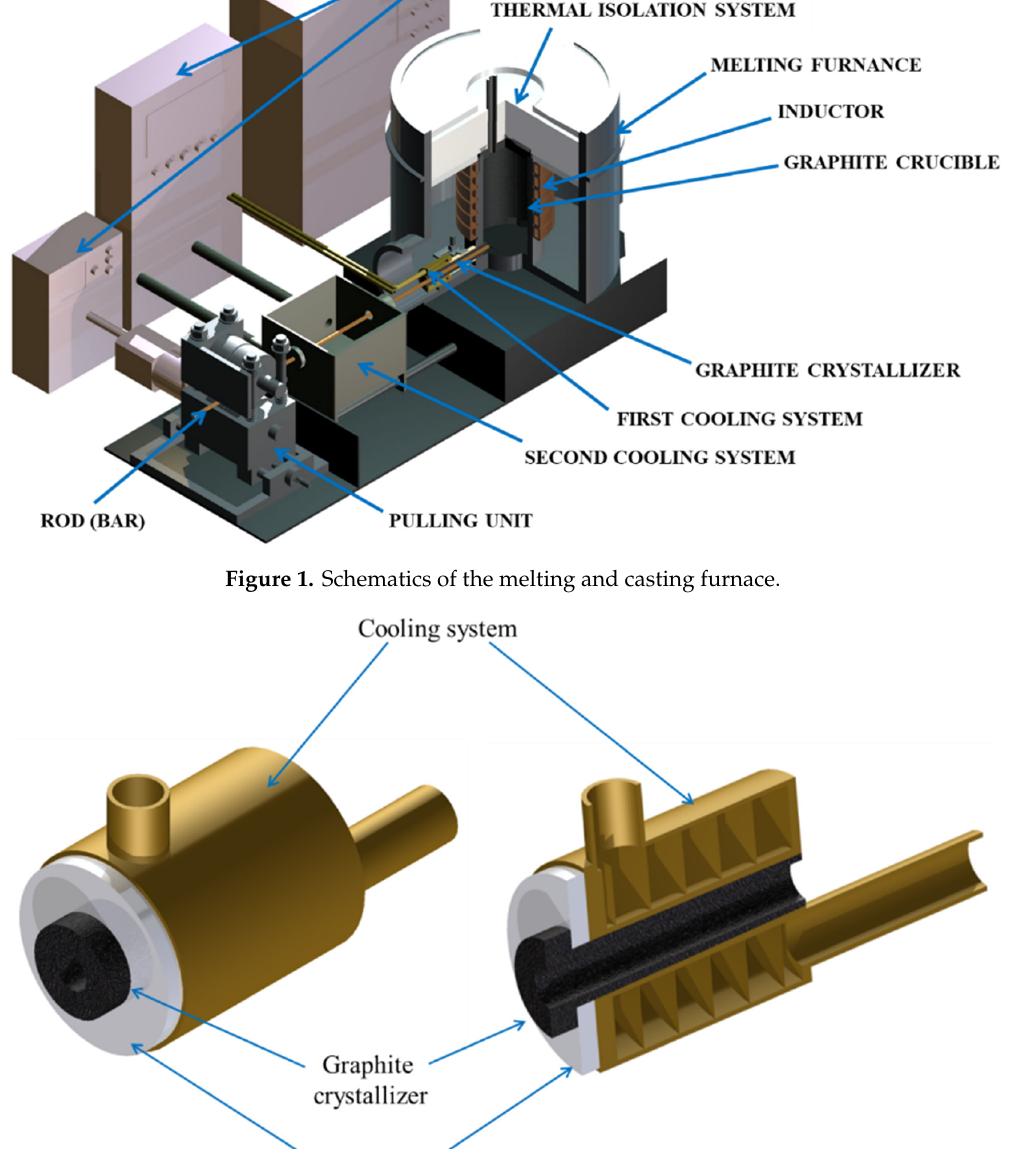
Figure 2. Schematics of graphite crystallizer with primary cooling system.